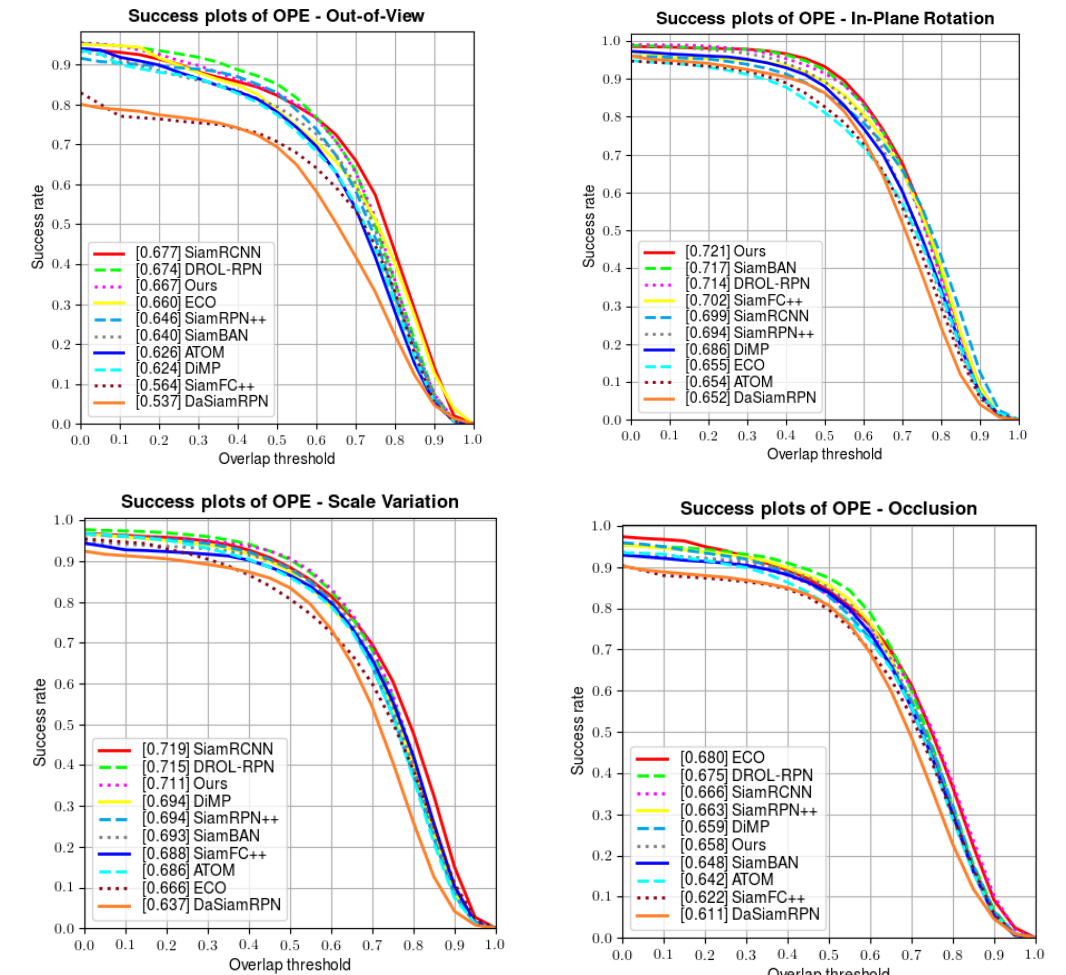
Figure 6. Comparisons of the attributes on OTB100.